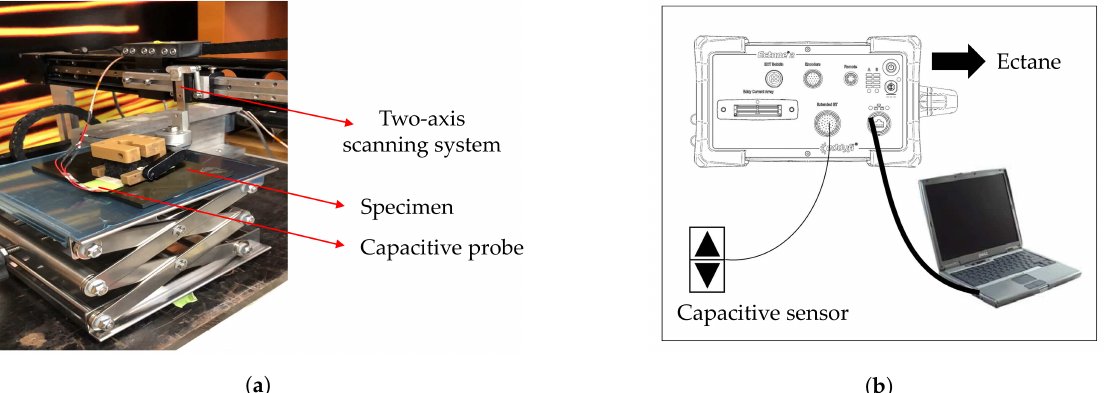
Figure 8. ( a ) The experimental arrangement used for the capacitive imaging and ( b ) typical configuration: Ectane with the capacitive